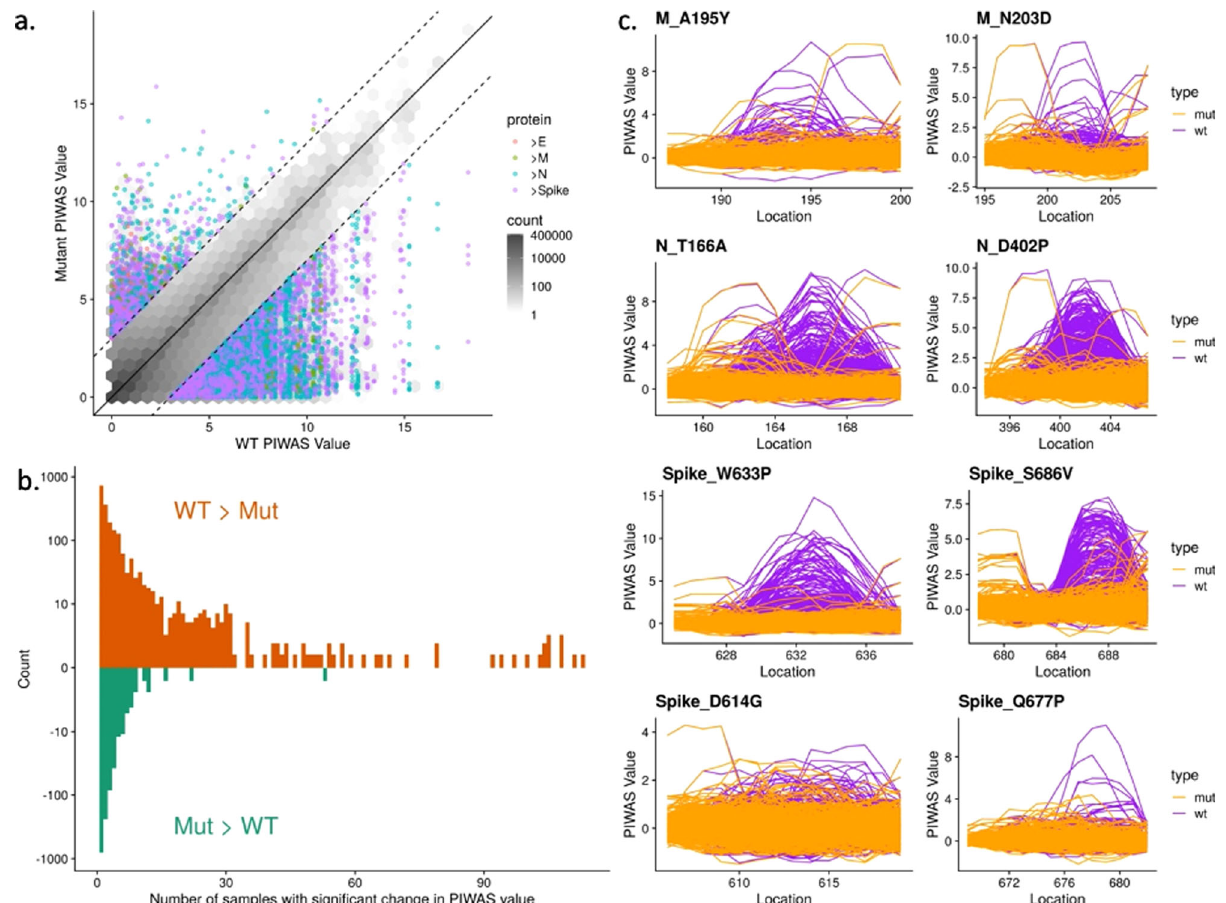
Fig. 6 Mutations to SARS-CoV-2 are biased towards decreasing immune epitope response. 21,127 distinct amino acid mutations in spike glycoprotein, nucleoprotein, envelope protein, and membrane protein in SARS-CoV-2 strains were identi fi ed from sequencing data of 96,437 genomes from GISAID. a For each mutation, the PIWAS value of the wild-type (WT) sequence was compared to the PIWAS value for the mutated strain (mut). b Mutations conferring a signi fi cant PIWAS value change (|PIWAS WT -PIWAS mut | > 3) for each COVID-19 sample were identi fi ed. For each mutation, the number of patients with a signi fi cant difference was counted. c Exemplary mutations that yielded a decrease in PIWAS values are shown for membrane protein (top row), nucleoprotein (middle row), and spike (bottom row). No signi fi cant immune signal is seen at location 614 of spike, for either the wild-type or the D614G variant. The Q677P mutation in spike resulted in a loss of signal at that